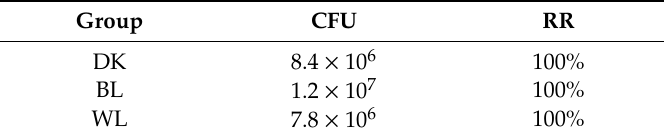
Table 1. Results for the cDNA library quality